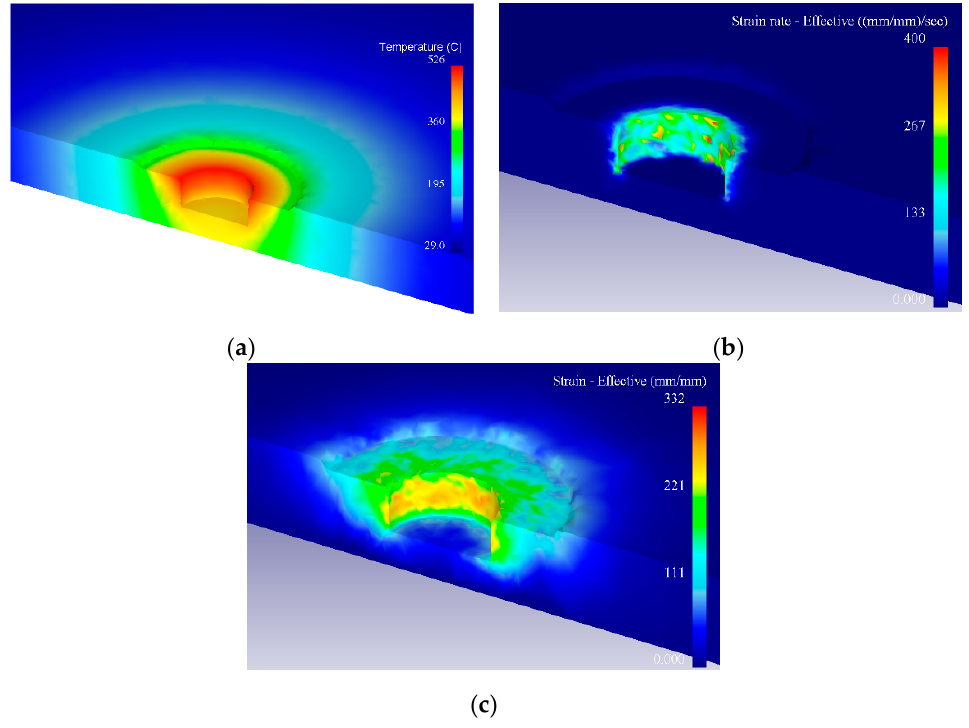
Figure 12. Distribution of field data in workpiece at the end of the FSSW process using a tool rotating speed of 1600 rpm: ( a ) temperature distribution; ( b ) effective strain rate distribution; ( c ) effective strain distribution.